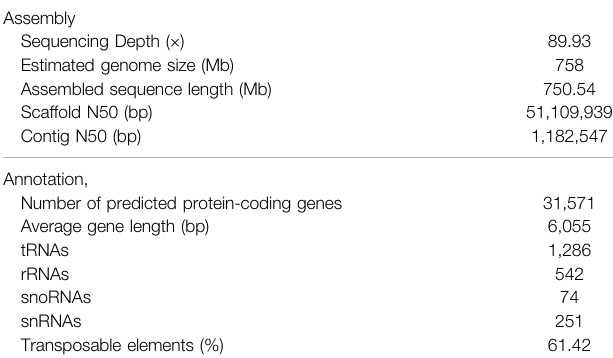
TABLE 1 | Summary of the M. tetraphylla genome assembly and annotation. Assembly Sequencing Depth